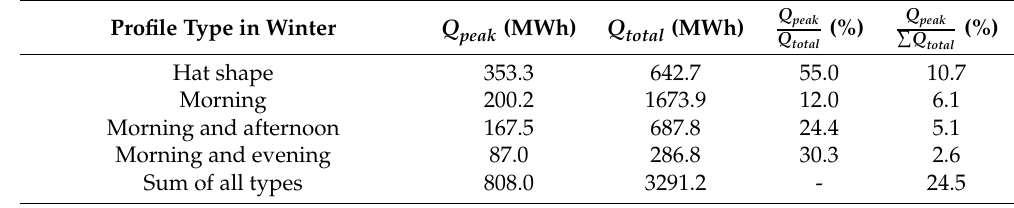
Table 7. Peak load quantification and the load sifting potential, based on categories in the winter and transition season of